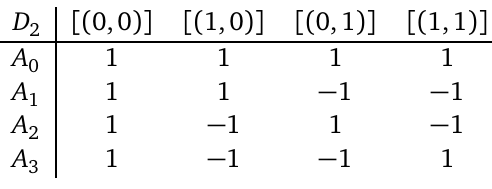
Table 3: The character table of D